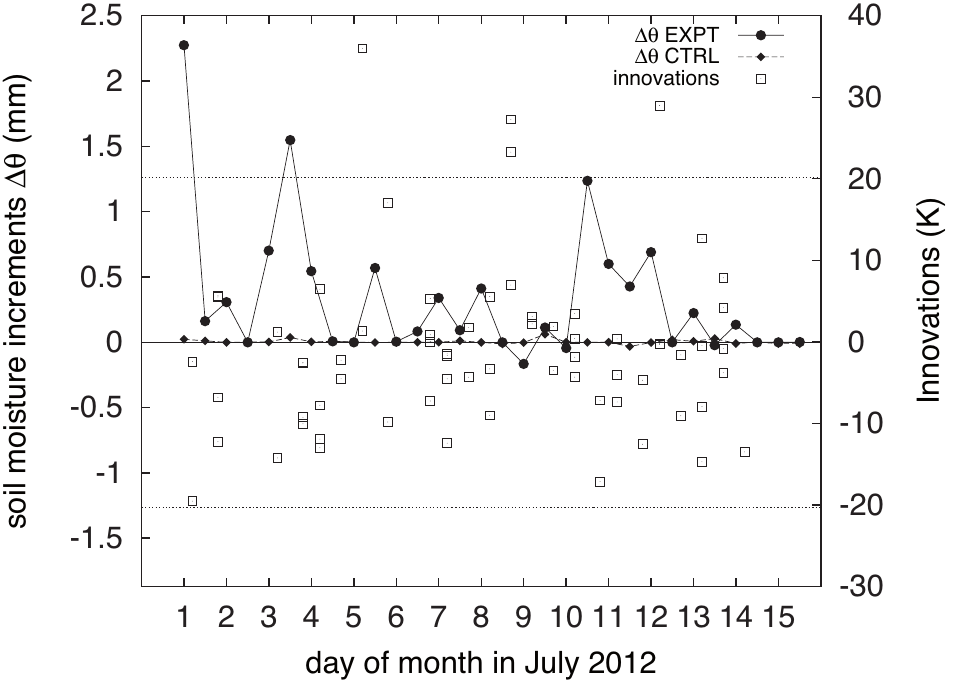
Figure 10. Soil moisture increments of the top layer (0–7 cm) at 00UTC and 12UTC for CTRL (assimilation of only screen-level variables, dashed line and filled diamonds) and EXPT (assimilation of screen-level variables and SMOS T , solid line and filled dots) B experiments. Overlapped to the increments, the difference between each observation after bias correction and the model equivalent (innovations, squares) are shown. The limits of the first-guess check [ (cid:0) 20, 20] K are also represented by dotted lines. The location of the grid point is Vinklumpsvägen, Sweden [lat = 64.10, lon =